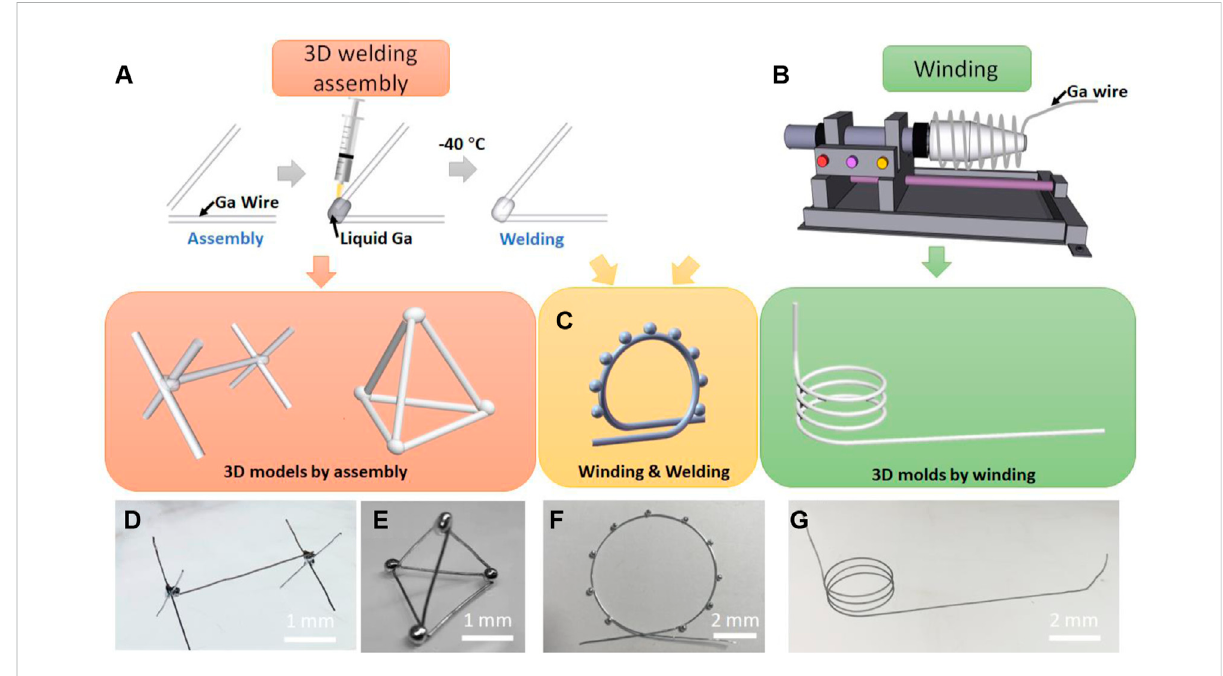
FIGURE 2 Creation of LM molds. (A) 3D LM microstructures by welding. (B) 3D LM microstructures by winding. (C) 3D LM microstructures by a hybrid method that combines the welding and winding. (D) A free-standing LM bridge. (E) A free-standing LM tetrahedron. (F) A LM “ Ferris wheel ” . (G) A 3D spiral